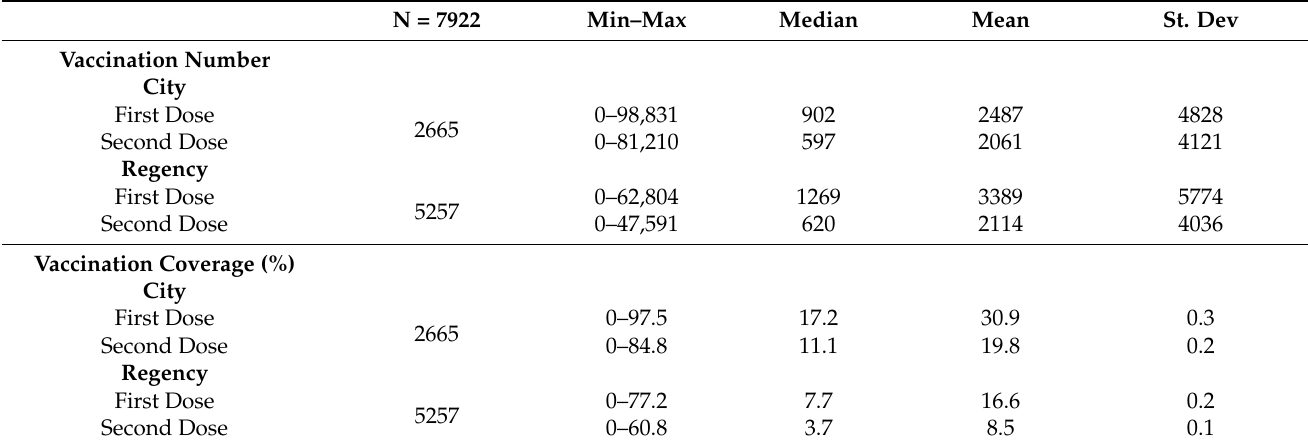
Table 1. Summary of vaccination data in West Java (13 January–23 November